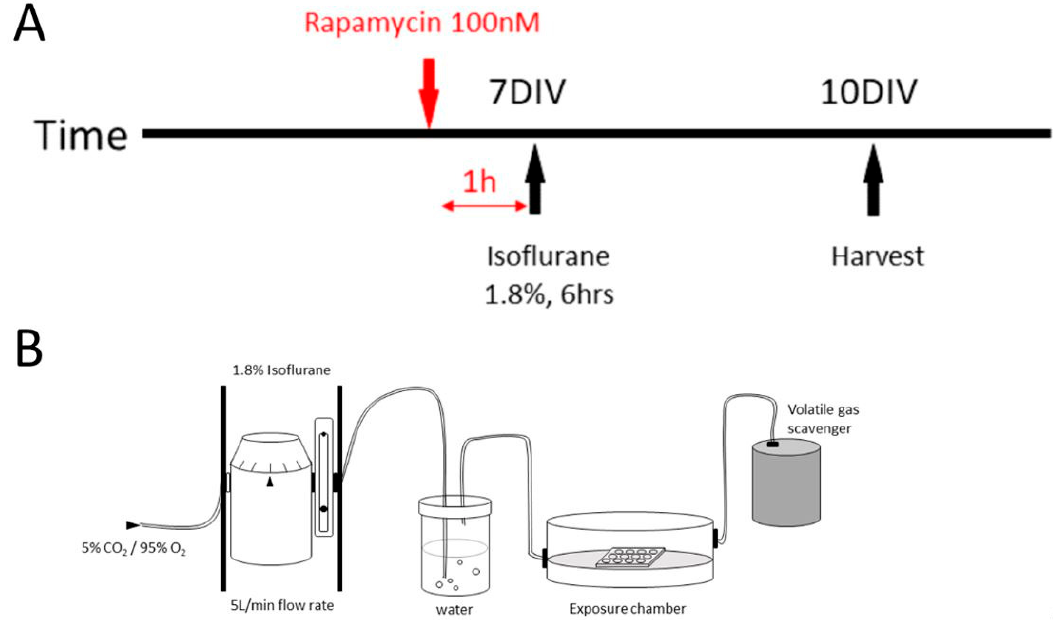
Figure 2. Schematic representation of the experimental timeline and exposure induction diagram in